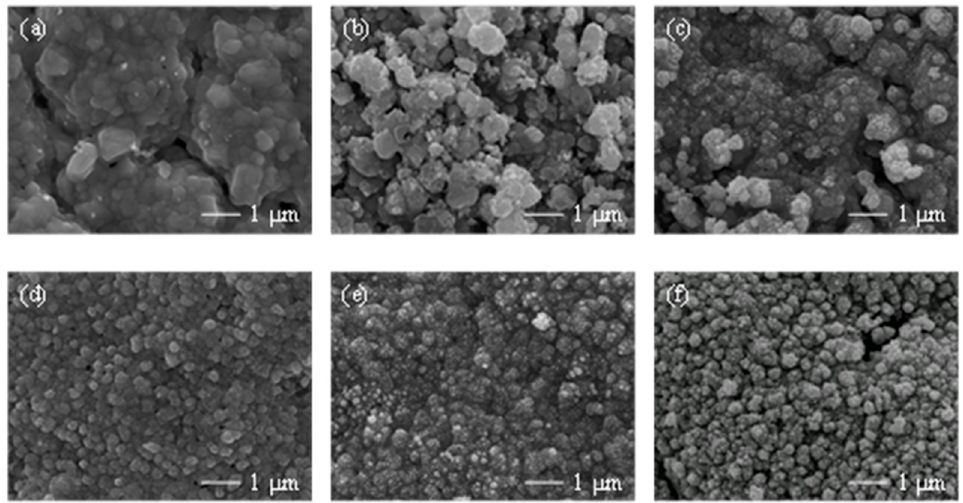
Figure 3. SEM images of ( a ) CdS / CuInS 2 , ( b ) Pt 0.22 / CdS / CuInS 2 , ( c ) Pt 0.44 / CdS / CuInS 2 , ( d ) Pt 0.66 / CdS / CuInS 2 , ( e ) Pt 0.88 / CdS / CuInS 2 , and ( f ) Pt 1.00 / CdS / CuInS 2 .